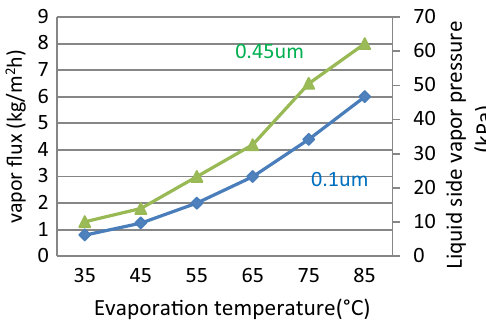
Fig. 10 Effect of evaporation temperature on vapor flux in